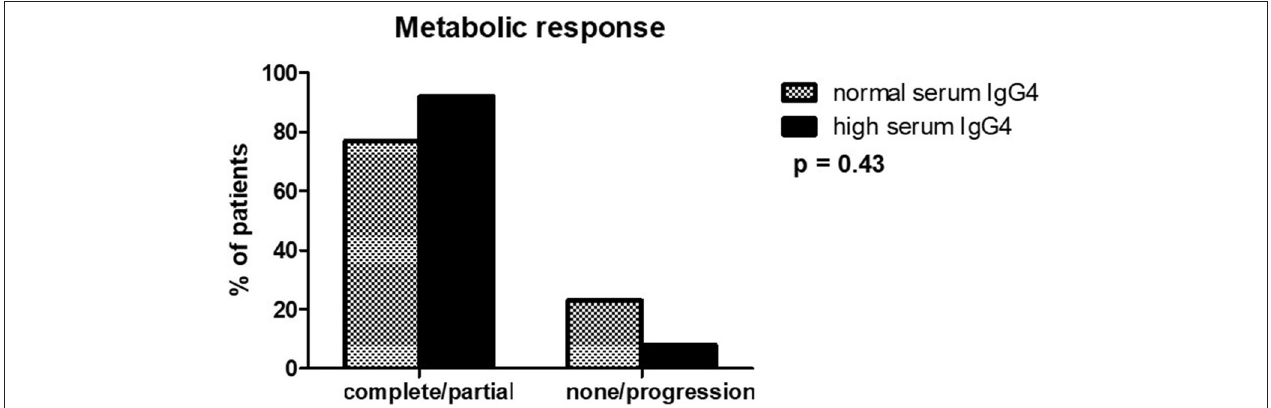
FIGURE 3 | Metabolic response to treatment assessed by FDG-PET in patients with high and normal serum IgG4 levels. Responses were evaluated as described in the text (see Methods section).